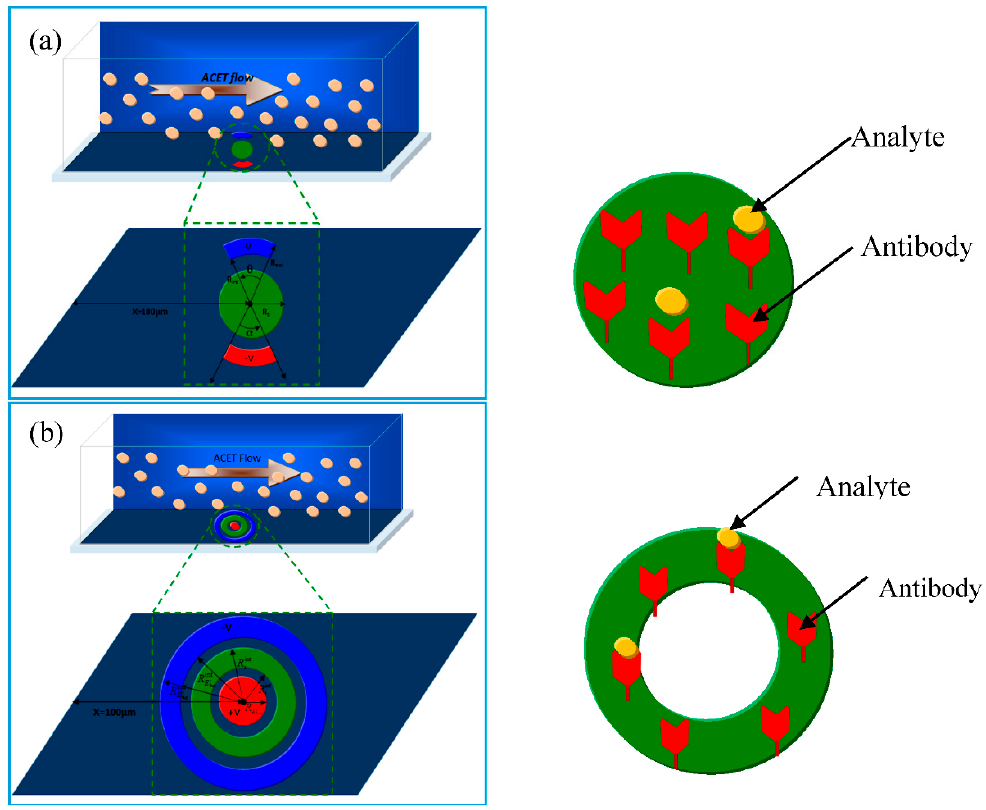
Figure 1. Sketch of two types of 3D models of a microfluidic biosensor. The channel dimensions (length, width, and height) are respectively 250, 50, and 40 µ m: ( a ) First configuration: the detection surface is a disk; ( b ) second configuration: the detection surface is a ring.